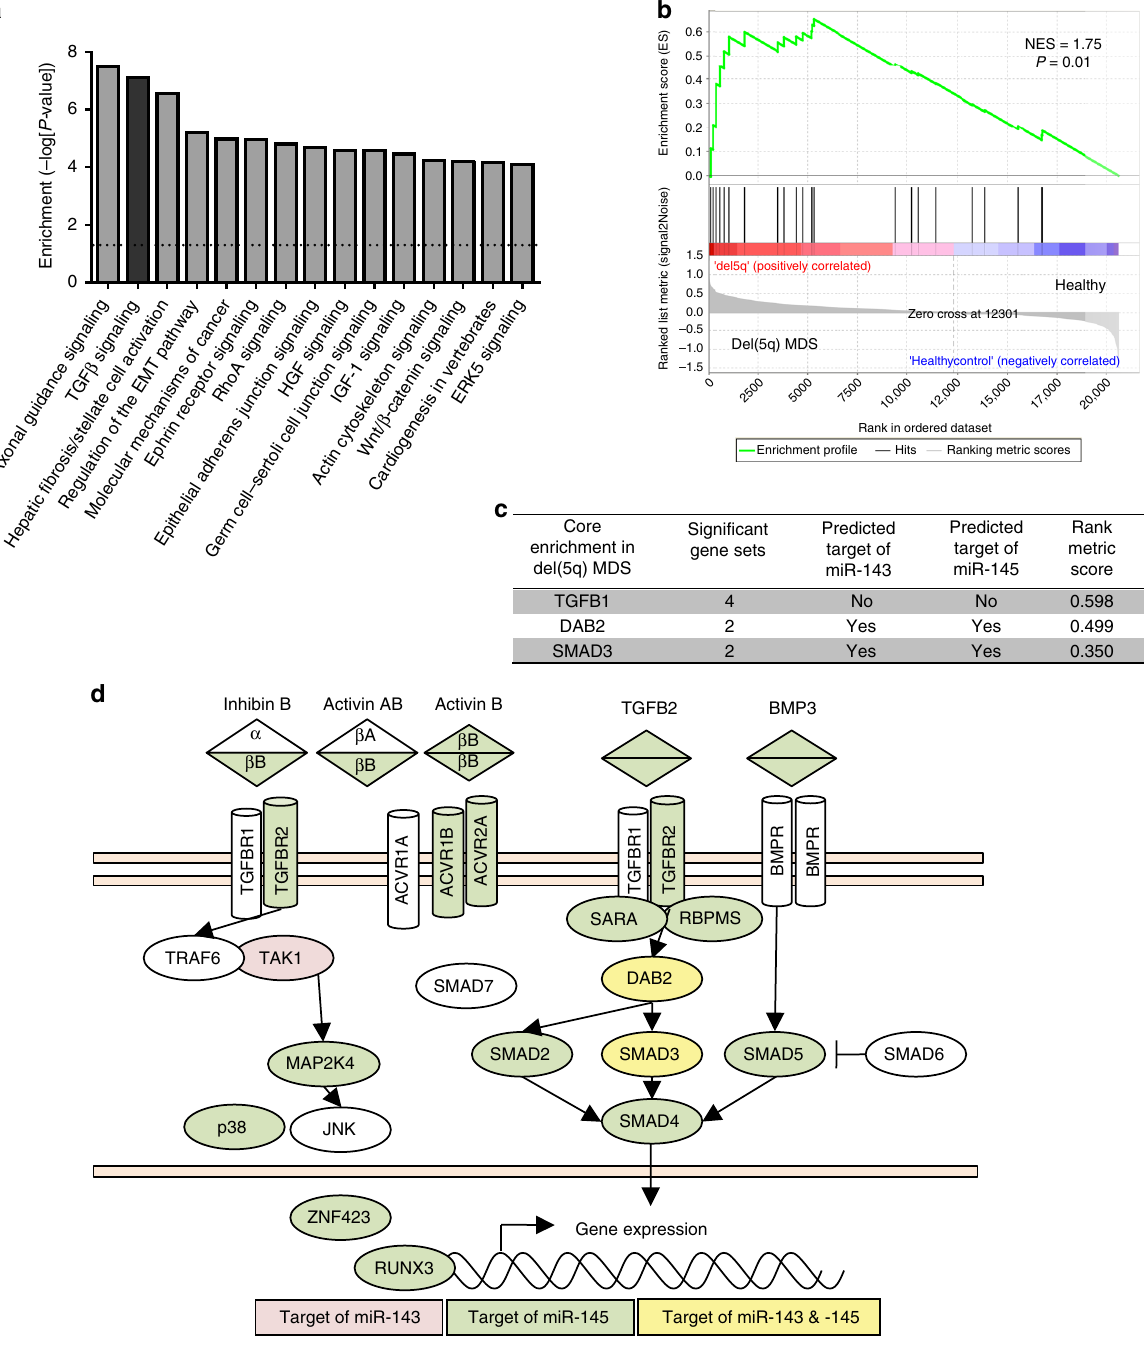
Fig. 2 miR-143 and miR-145 are predicted to target the TGF β signaling pathway. a Ingenuity pathway analysis of predicted human miR-143/145 target genes curated from Target Scan v6.2. b GSEA enrichment plot for the gene set “ GO_POSITIVE_REGULATION_OF_CELLULAR_RESPONSE_TO_ TRANSFORMING_GROWTH_FACTOR_BETA_STIMULUS ” , a top gene set enriched in del(5q) MDS vs. healthy controls, from published gene expression data. c Leading edge analysis of the top (FDR ≤ 0.05) fi ve differentially enriched gene sets in del(5q) bone marrow, relative to healthy bone marrow, identi fi es only three genes present in multiple gene sets, ranked by the GSEA rank metric score. Whether these genes are predicted targets of miR-143 or miR-145 is also indicated. d Predicted miR-143/145 target genes in the context of the TGF β